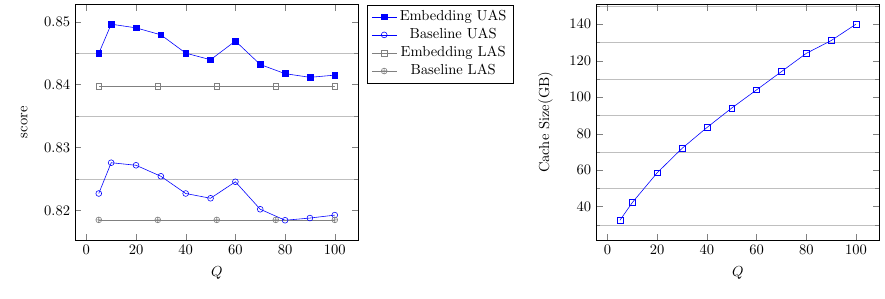
Figure 4. The parsing accuracy and cache size under different Q .